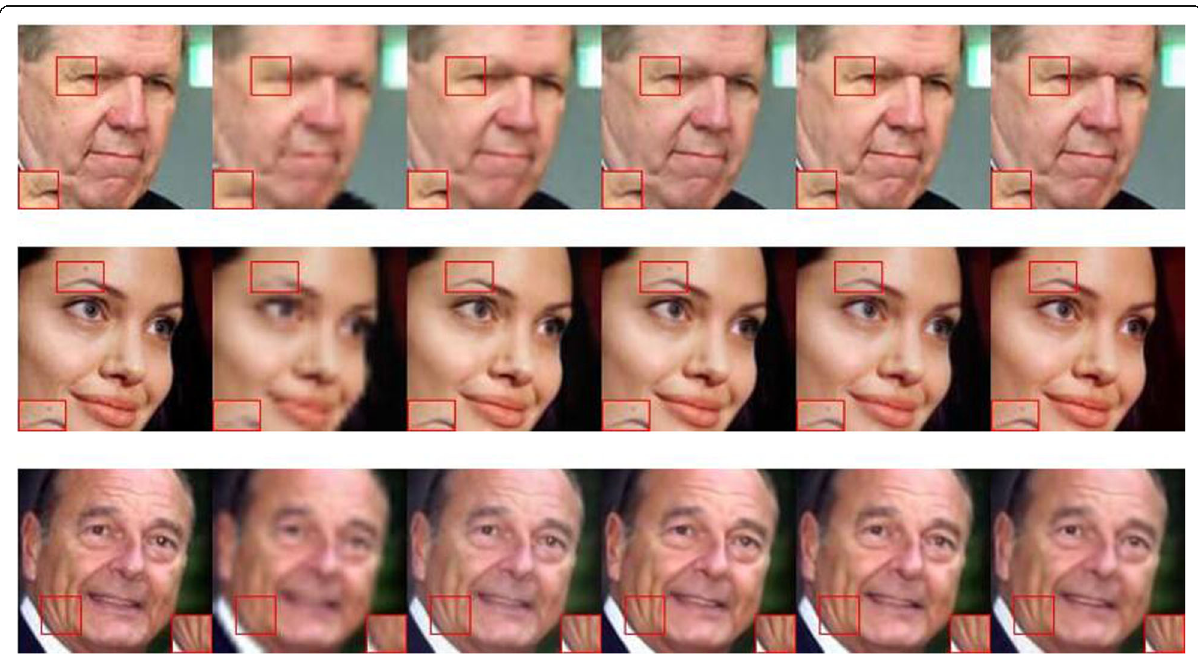
Fig. 8 Reconstructed images by different methods (scale =